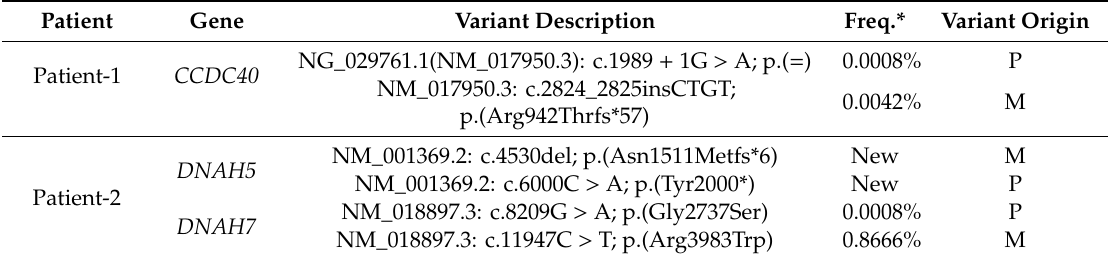
Table 1. List of pathogenic variants found in Patient-1 and